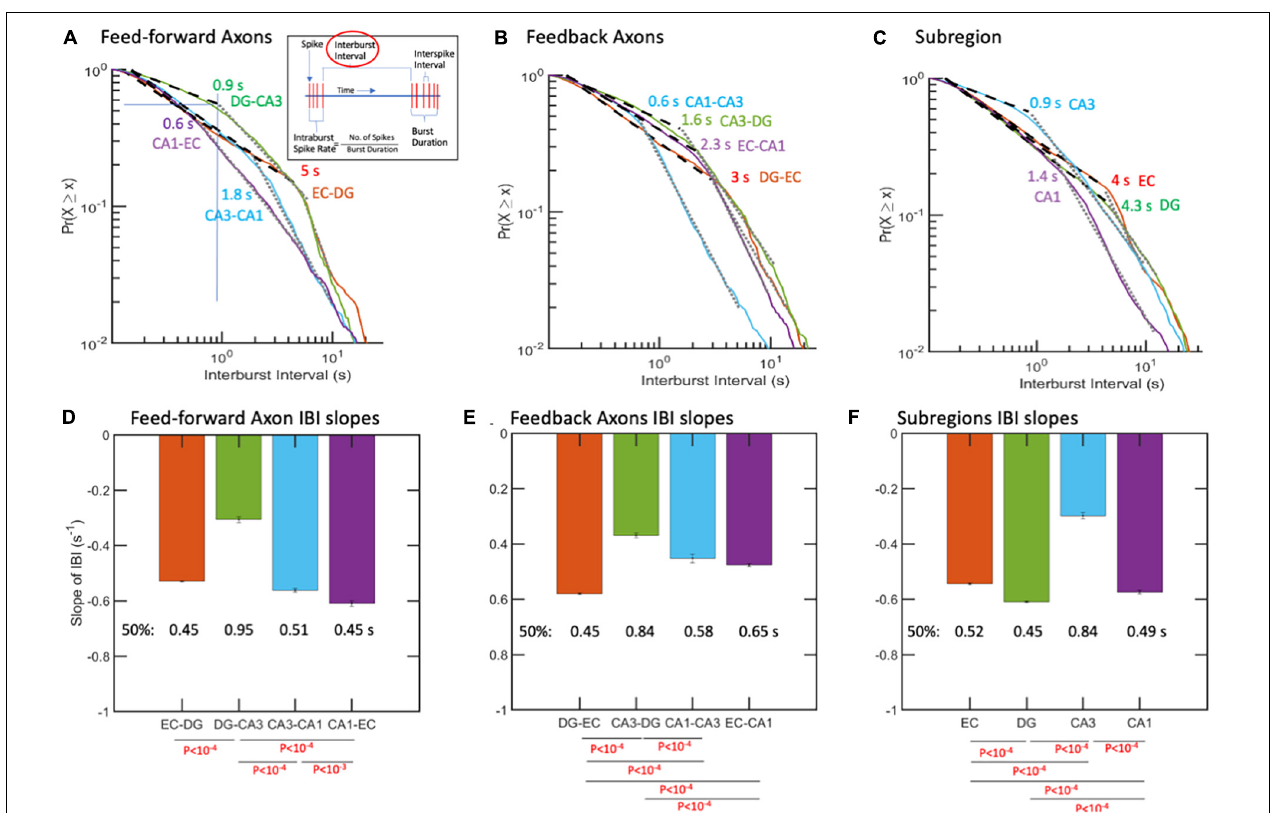
FIGURE 5 | Inter-burst Intervals (IBIs) follow piecewise log-log distributions, suggesting up-down states. Points where log-log fits changed to a steeper slope are enumerated. (A) Feed-forward axons with least time of main state in DG-CA3 (most shallow slope), suggesting low range of up states compared with other axons there. Fifty percent of the up-states in DG-CA3 FF axons occur at times less than 1 s (horizontal and vertical lines). In contrast, 50% of the other feed-forward axons have IBIs of about 0.5 s. (B) Feedback axons in CA1-CA3 appear to switch from a domain of short inter-burst intervals to a longer domain around 0.6 s. (C) In the subregions, CA3 neurons switch from faster bursts to slower bursts around 0.9 s, while the transition in DG occurs only after 4.3 s. R 2 > 0.99 for all fits. IBIs for (D) feed-forward axons, (E) feedback axons, and (F) subregion neurons. Least frequent bursting (longer IBIs) was in DG-CA3 feed-forward axons and CA3 subregion neurons. The error bars in the graphs represent the 95% confidence intervals obtained by ANCOVA. P -values calculated by ANCOVA followed by Tukey-HSD.